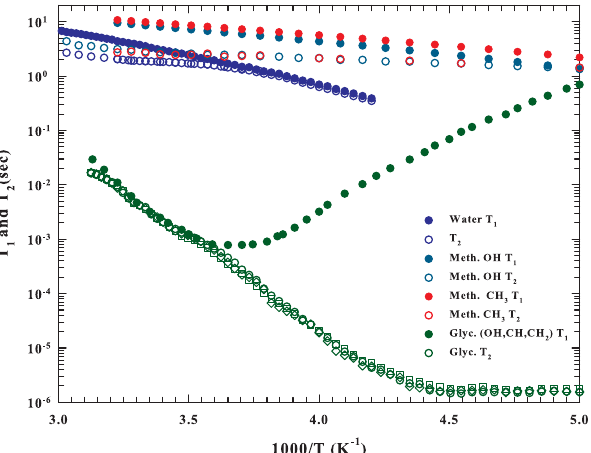
Figure 3. The Arrhenius representation of the measured spin–spin T 2 and spin–lattice T 1 relaxation times for water, methanol, and glycerol. For methanol and glycerol, the behavior of all of their dif- ferent hydrophilic (OH) and hydrophobic groups (methine CH, methylenes CH 2 , and methyl CH 3 ) are reported.